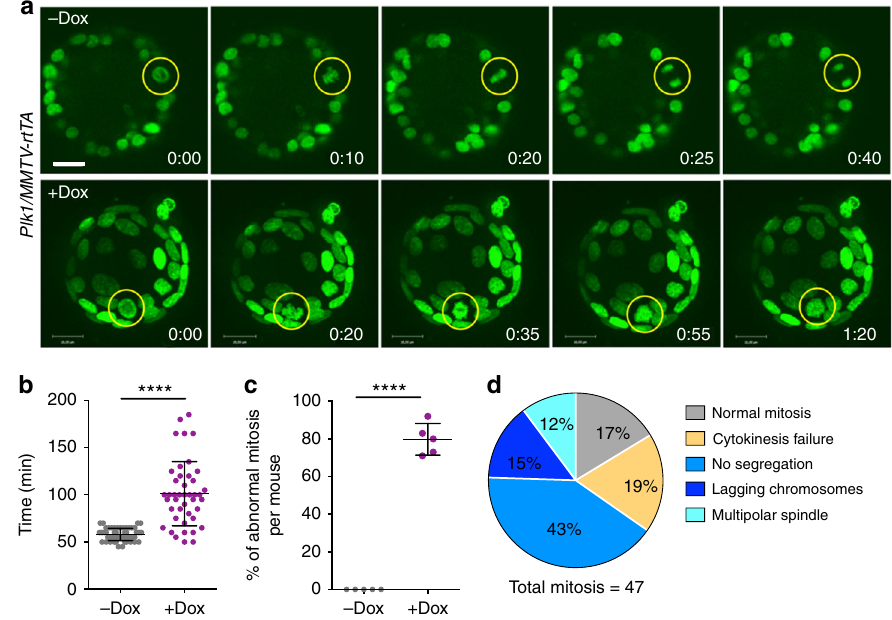
Fig. 7 Mitotic aberrations in cultured Plk1-overexpressing mammary organoids. a Time-lapse microscopy of Plk1/MMTV-rtTA mammary organoids expressing H2B-GFP either untreated (upper panel) or after 24 h on Dox (lower panel). Yellow circles indicate mitotic cells; H2B-GFP (green). Scale bar, 18 μ m. b Duration of mitosis in the organoid cultures ( – Dox, 57 cells; + Dox, 43 cells). c Percentage of mitotic errors per mouse ( – Dox, 57 cells from 5 mice; + Dox, 47 cells from 5 mice). In b , c , **** p < 0.0001, Student ’ s t -test. d Classi fi cation of mitotic phenotypes in organoid cells overexpressing Plk1 after 36 h